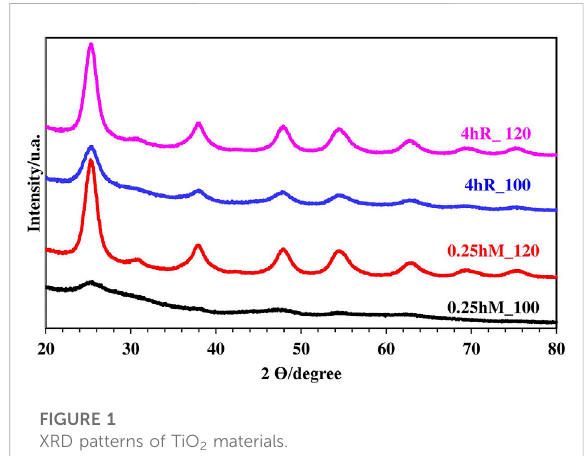
FIGURE 1 XRD patterns of TiO 2